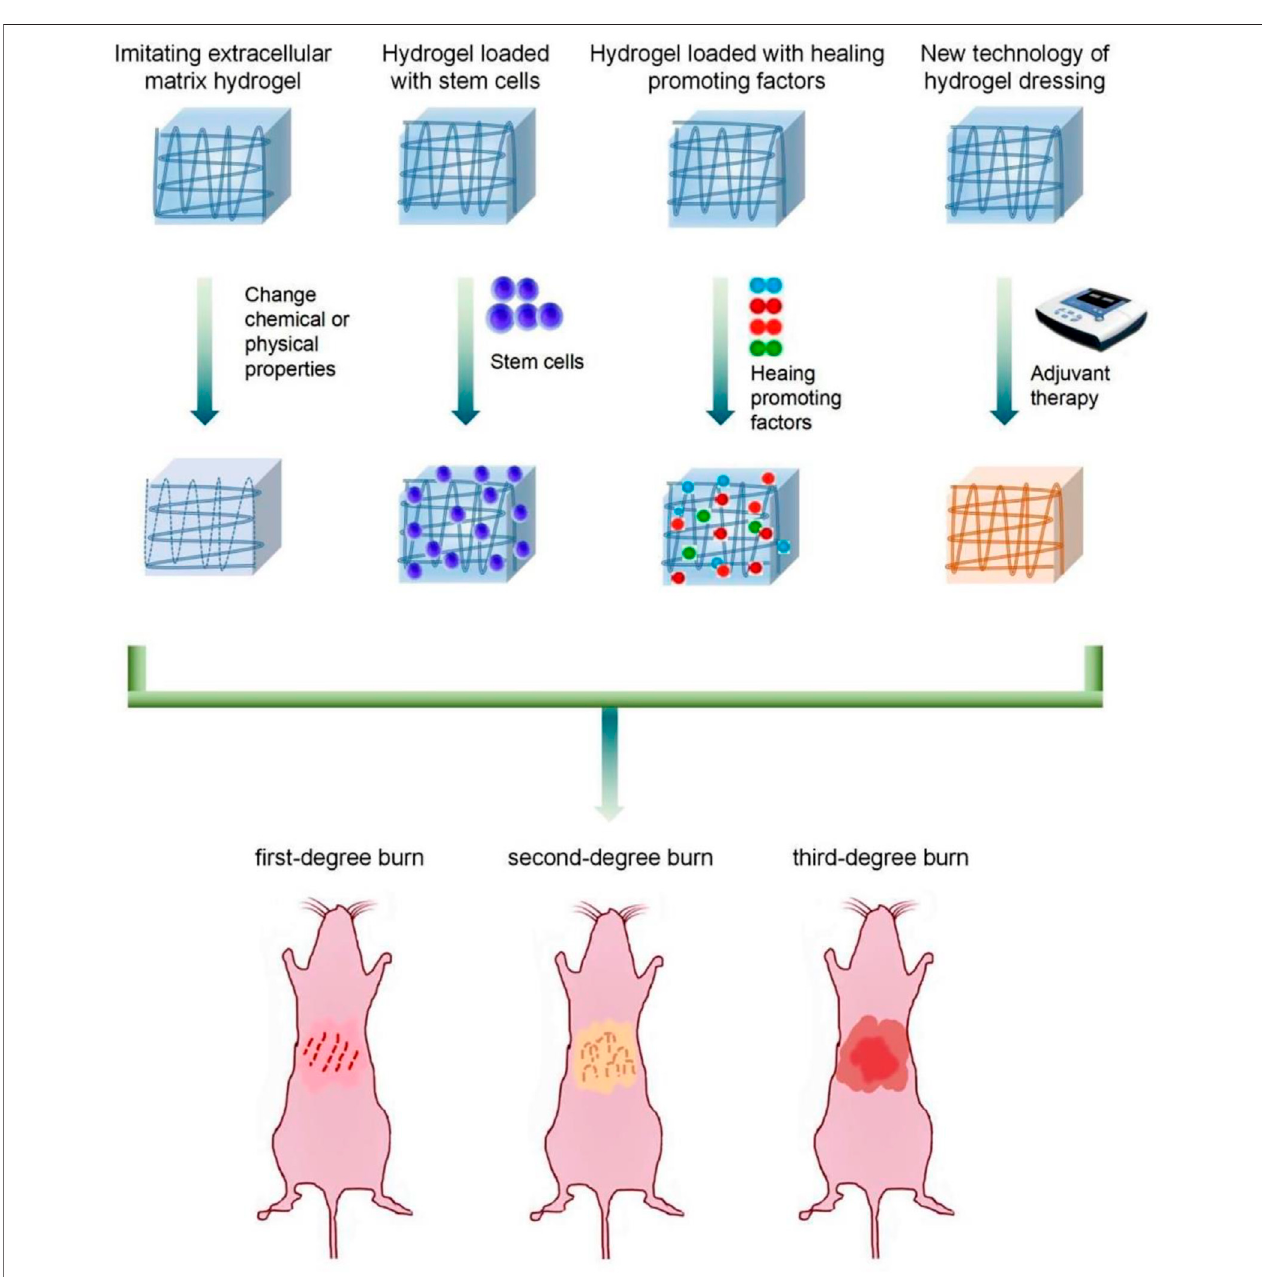
FIGURE3| Functional classi fi cation ofhydrogel dressings forburns: Imitatingextracellularmatrixhydrogel,Hydrogelloadedwithstemcells,Hydrogel loadedwith healing promoting factors, and New technology of hydrogel dressing.